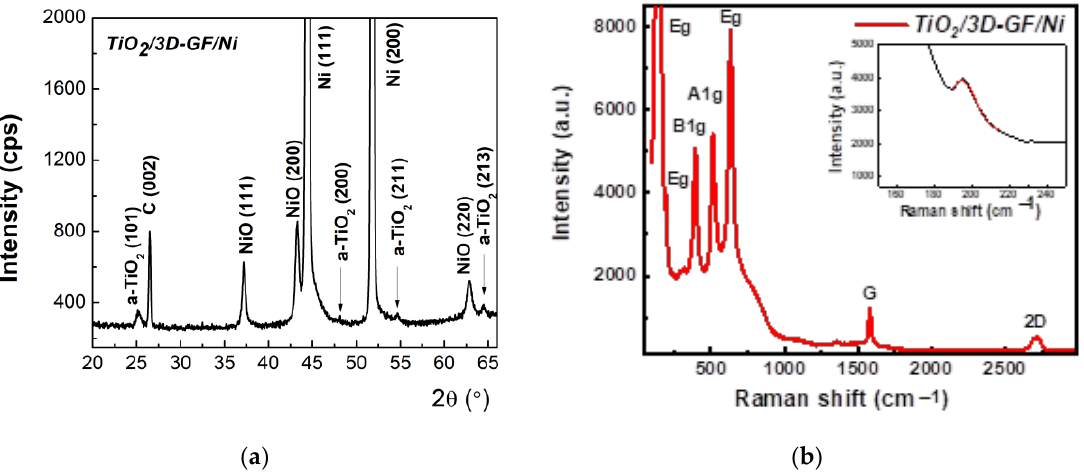
Figure 3. Structural characterization of the TiO 2 /3D-GF/Ni synthesized at a calcination temperature of 450 °C for 2 h. ( a ) XRD patterns and ( b ) Raman spectra, indicating the presence of both few-layer graphene on Ni scaffold and pure anatase phase.